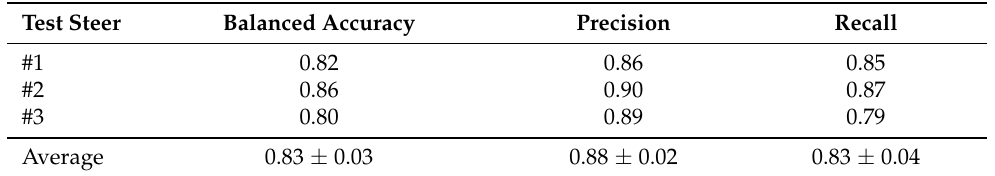
Figure 6. Number of reduction steps the features survived for MI and BFE selection methods. The (cid:5) annotations represent the seven features selected by BFE-LDA ‘ (cid:5) ’ and red bars the seven features that survived most reductions for each feature selection algorithm. Table 2. Individual classification performance per steer in terms of weighted performance metrics on the test